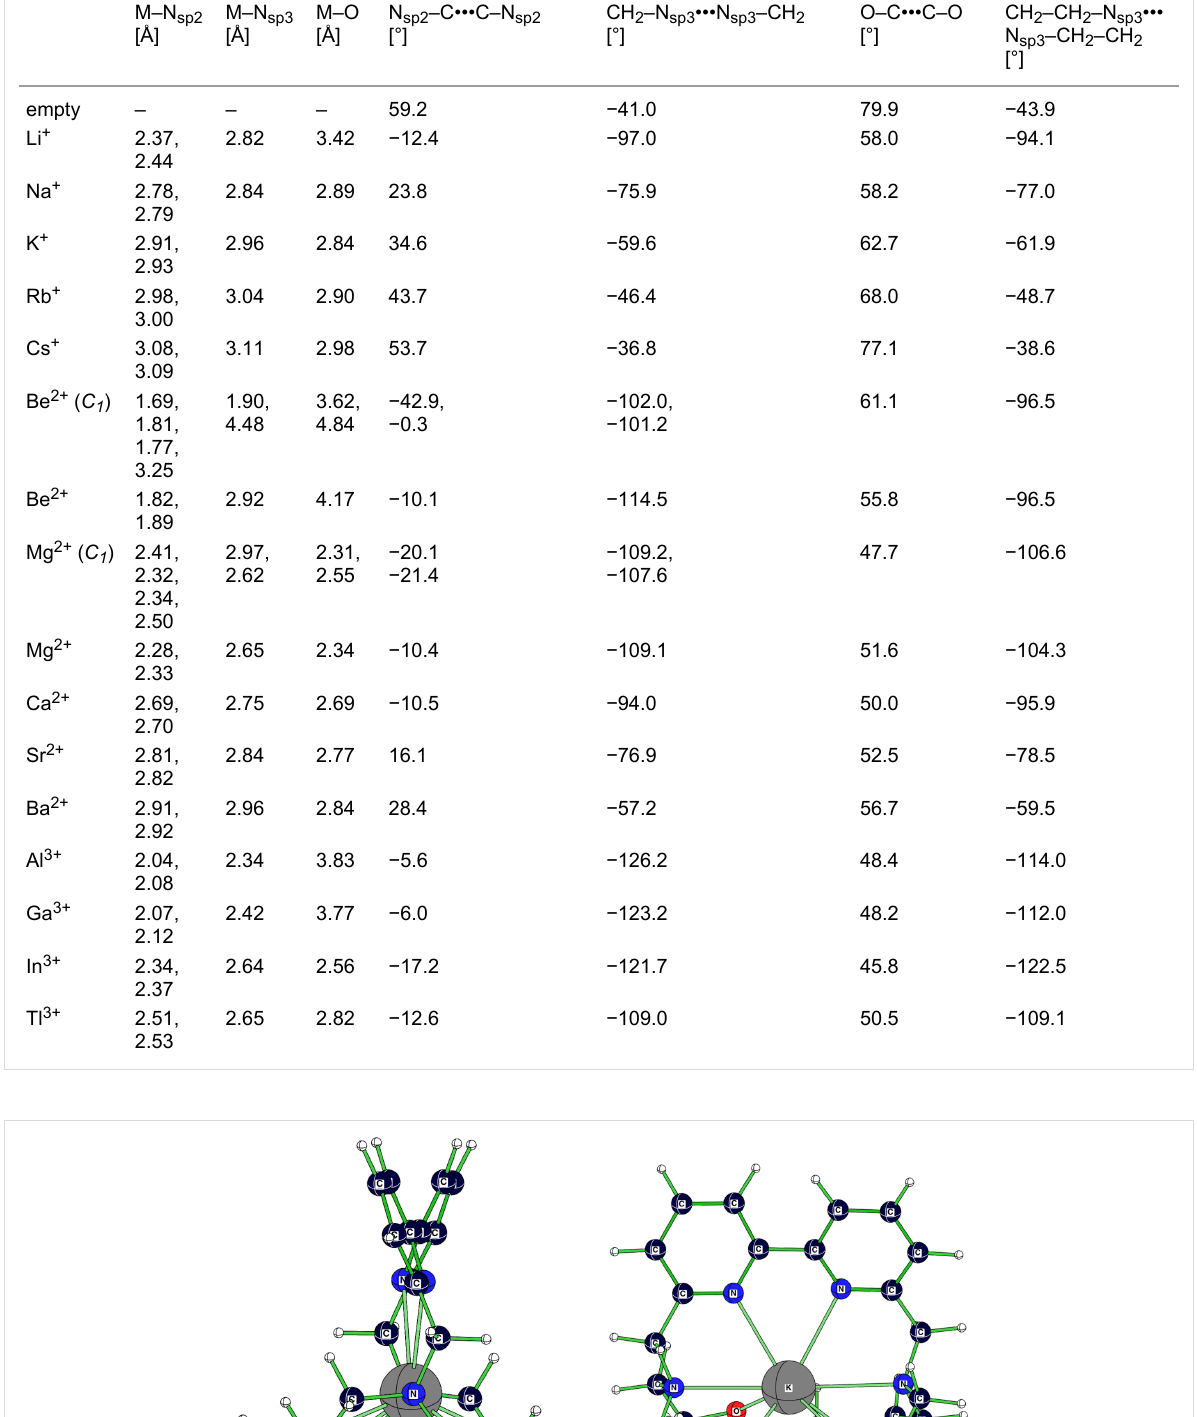
Table 2: Calculated (RB3LYP/LANL2DZp) structural data for the metal–donor interactions in [M 2.bpy.bpy] m+ (calculated structures: C 2 symmetry).